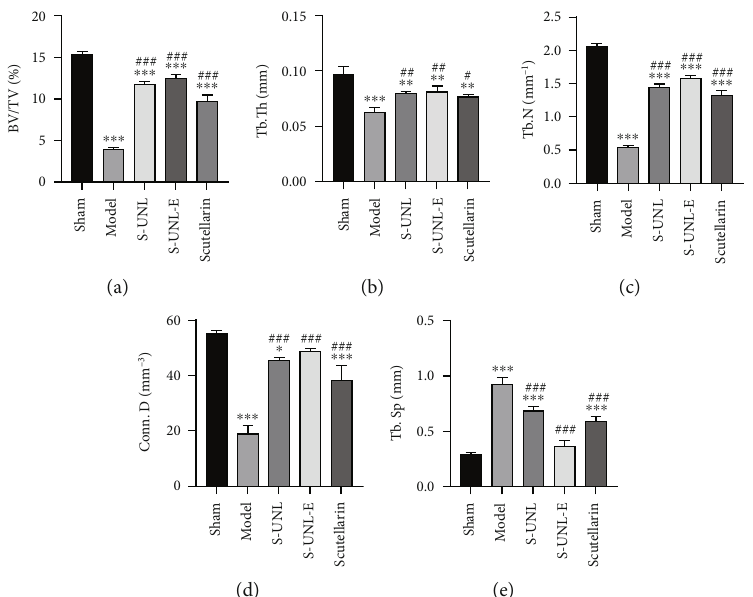
Figure 5: SUN-L-E promoted the bone healing in osteoporotic rats. (a) BV/TV (%). (b) Tb.Th (mm). (c) Tb.N (mm -1 ). (d) Conn.D (mm -3 ). (e) Tb.Sp (mm). ∗∗ p < 0 : 01 and ∗∗∗ p < 0 : 001 vs. sham. # p < 0 : 05 , ## p < 0 : 01 , and ### p < 0 : 001 vs.